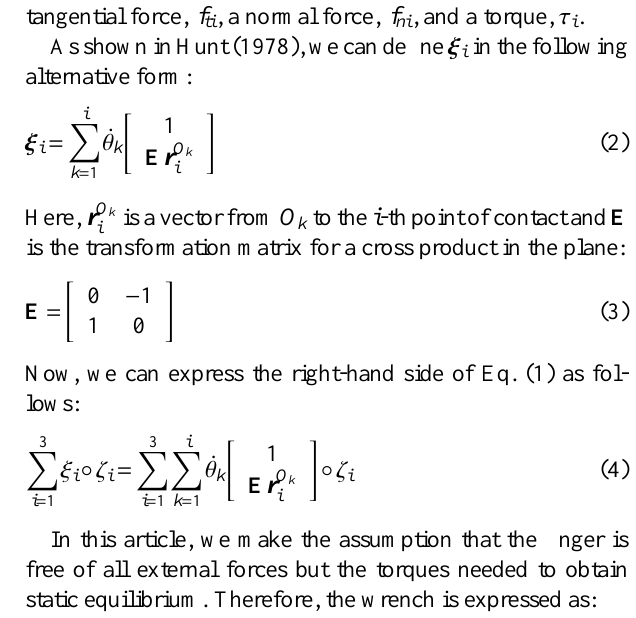
Fig. 1. FINGER WITH CORRESPONDING VARIABLES. Figure 1. Finger with corresponding